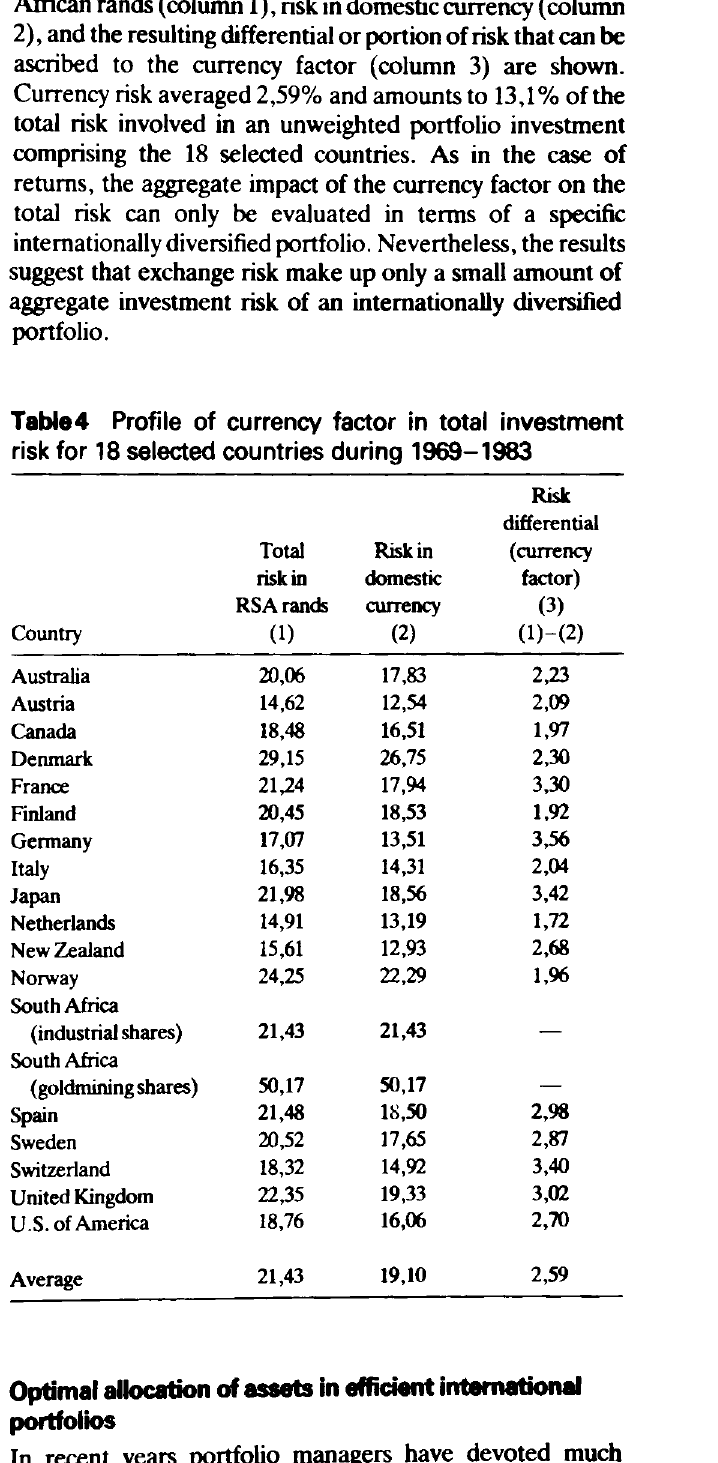
Table4 Profile of currency factor in total